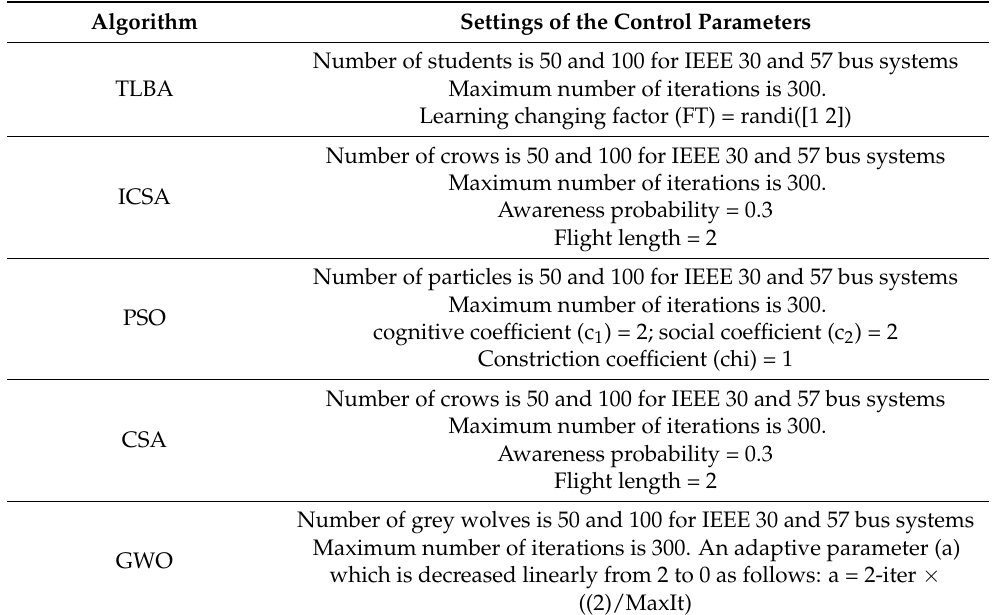
Table A1 tabulates the control parameter values used for TLBA, ICSA, PSO, CSA and GWO which are the methods established and reported in the comparisons. Table A1. Parameter settings for the methods that were